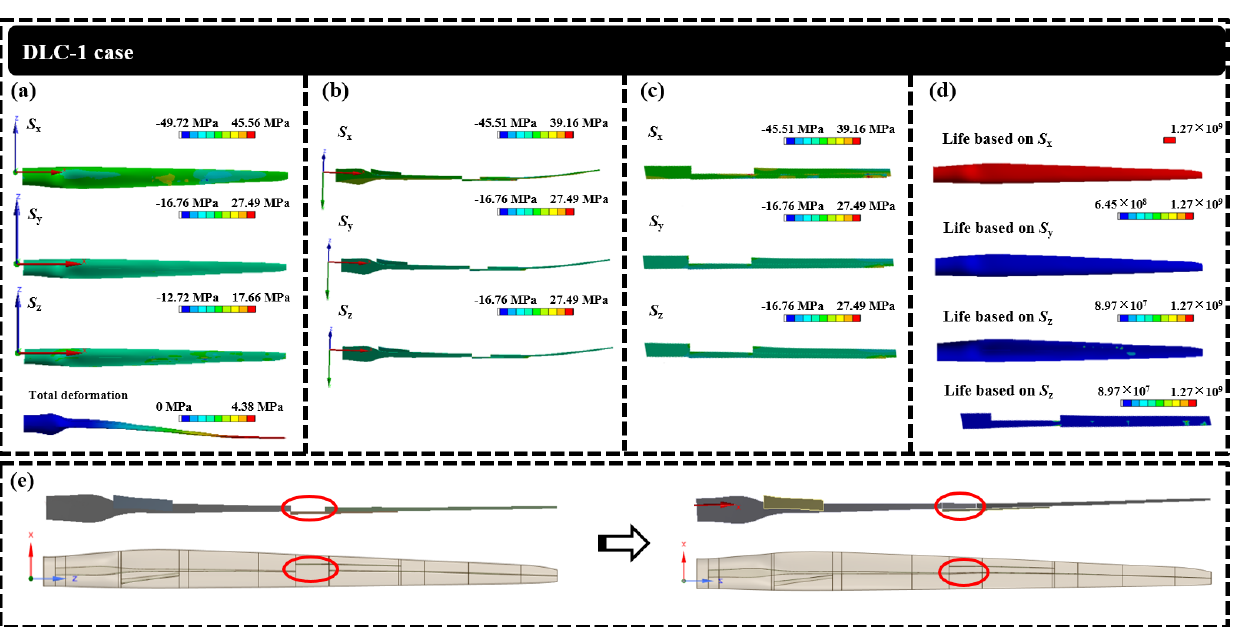
Figure 6. Validation of performance indexes for the first generation wind turbine blade in the DLC ‐ 1 case. ( a ) Stress and deformation contours of overall turbine blade. ( b ) Stress contours of internal structure. ( c ) Stress contours of localized regions of internal structure. ( d ) Fatigue life contours of whole turbine blade ( e ) The second generation design of the wind turbine blade. Table 5. Simulation results of the first generation wind turbine blade in the DLC-1 case. Overall Stress of Blade Localized Stress of Web Min. Fatigue Life Disp. of Tip Direction Max.